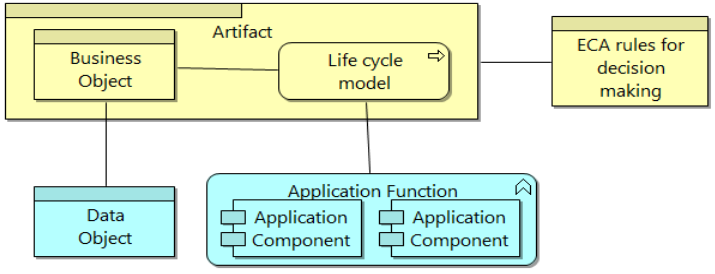
Figure 6. Enterprise model elements for monitoring CBP (business artifact-centric